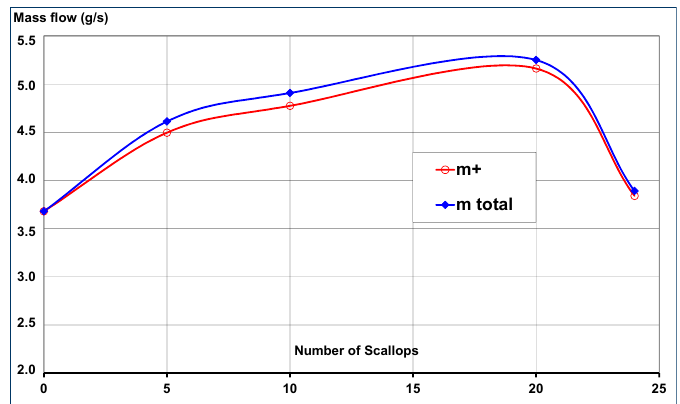
Figure 13. Impact of the number of scallops on the flow in a windback seal at a pressure ratio of 1.05, s = 0.3 mm and 15,000 rpm.